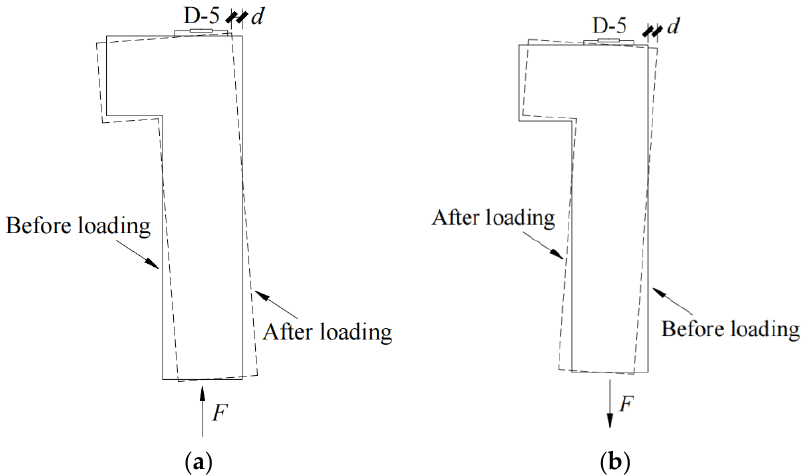
Figure 16. Schematic of the torsion of the specimen before and after loading: ( a ) positive loading (counterclockwise); and ( b ) negative loading (clockwise).